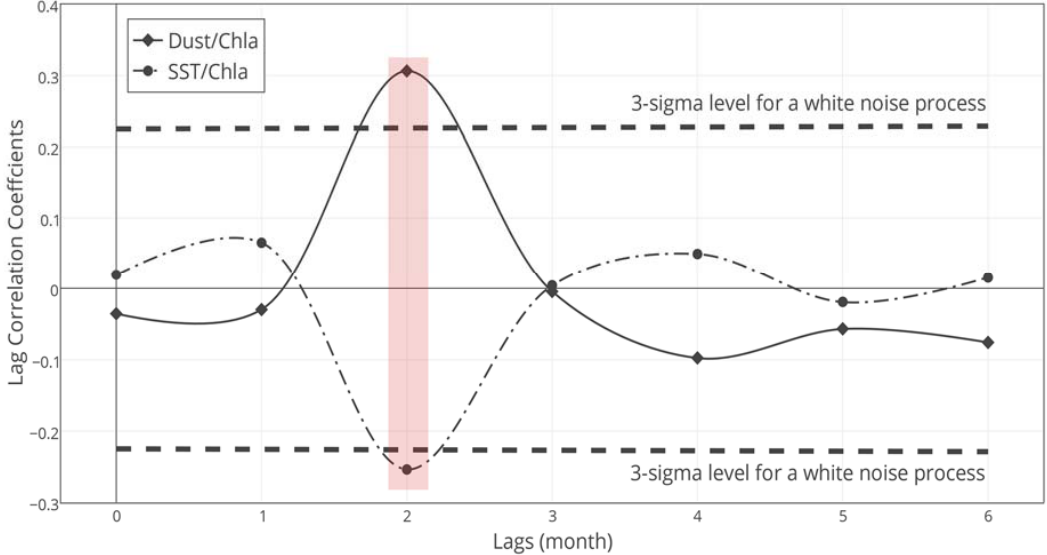
Figure 9. Monthly lag correlation between dust aerosol optical depth (DAOD) and Chl- a (solid) and SST and Chl- a (dot-dashed). Dashed lines show the limits of three standard deviations for a white noise process. The red box shows that the 2-month lag correlations exceed this level for both relationships.